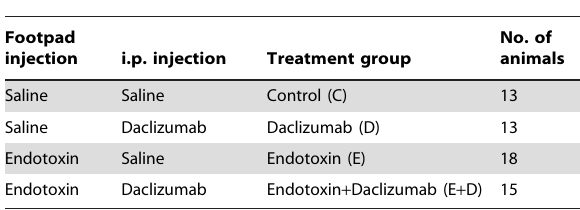
Table 1. Summary of treatment